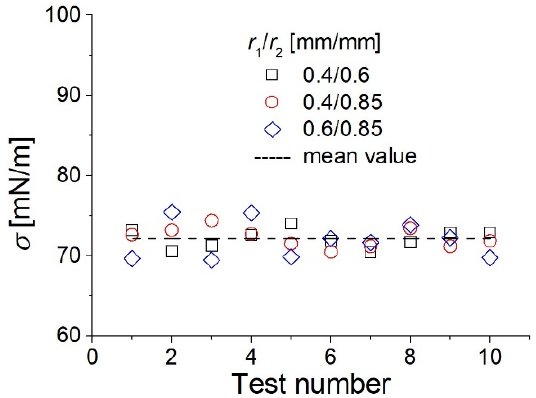
Figure 3. Surface tension of DW (distilled water) with different tube radius combinations in the differential capillary-rise-height method.